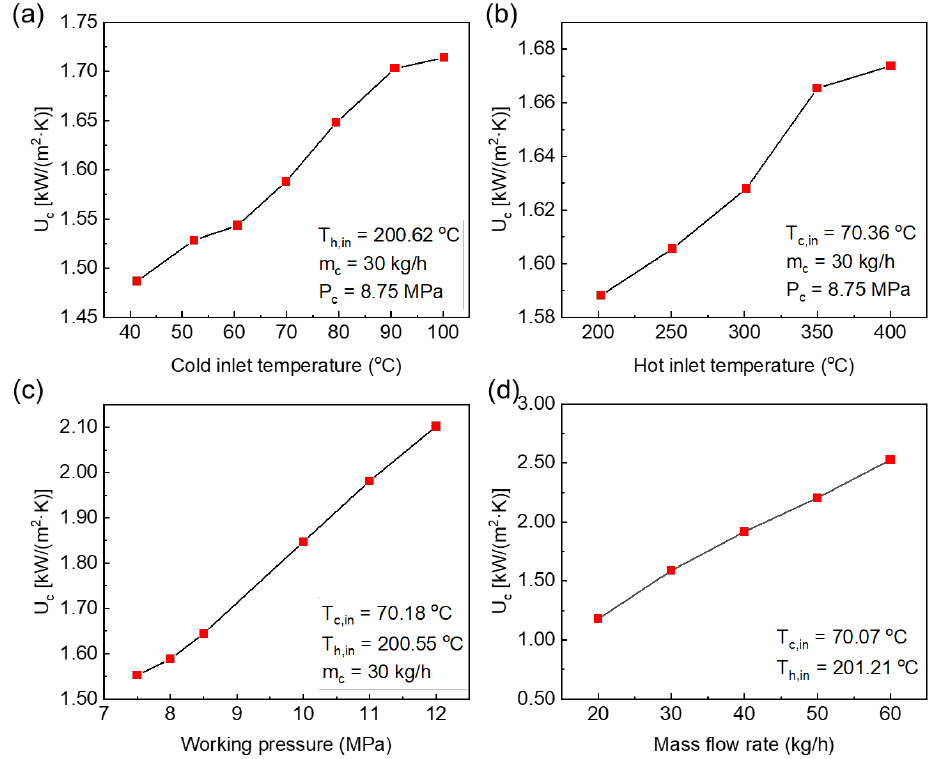
Figure 4. The effects of ( a ) cold inlet temperature, ( b ) hot inlet temperature, ( c ) working pressure, and ( d ) mass flow rate on the cold overall heat transfer coefficient.